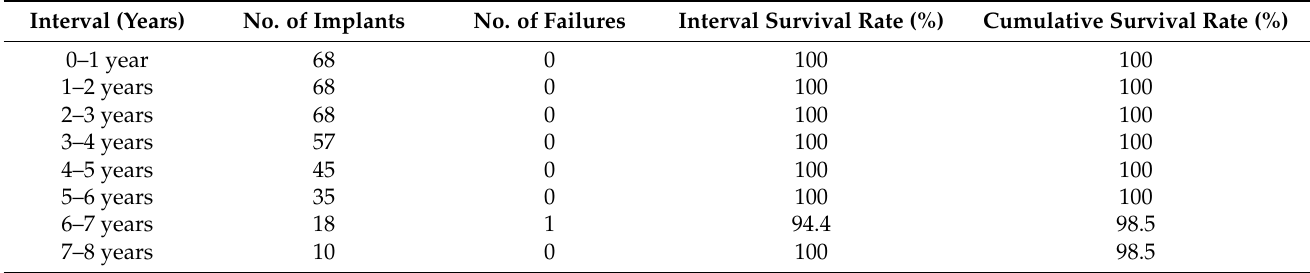
Table 5. Life table analysis on implant survival level in the non-bruxer